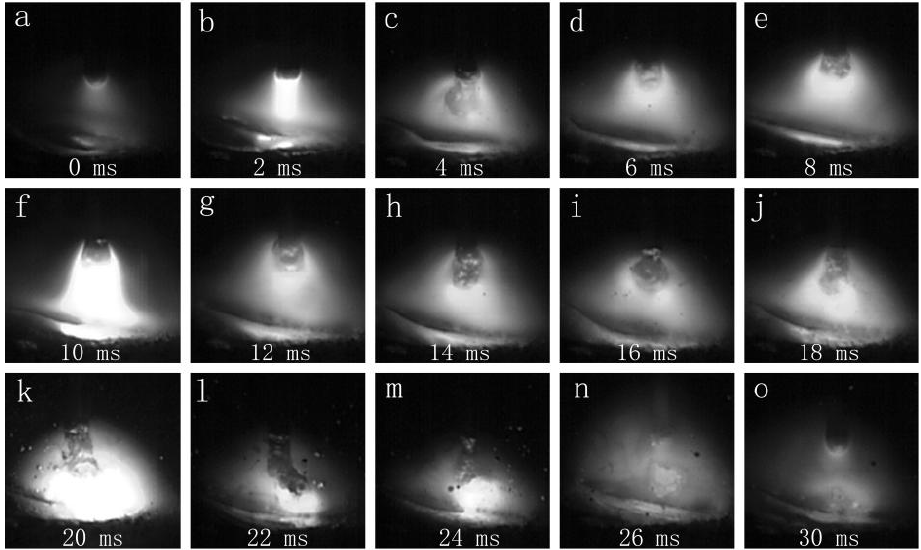
Figure 5. The droplet transfer process of the CMT+P mode (7150 filler wire): ( a – o ) show the droplet transfer process in chronological order.